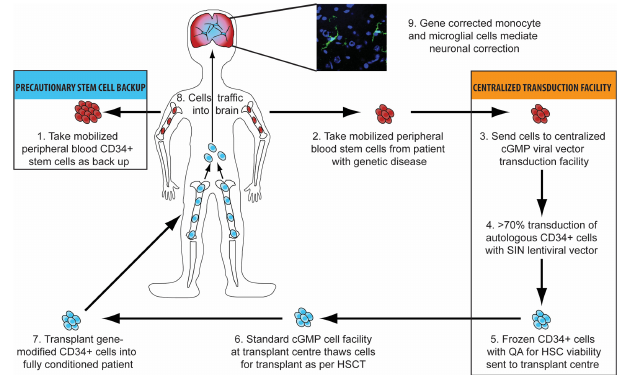
Figure 1. Schematic proposing how autologous stem cell gene therapy can be used to treat inherited neurological disorders. Mobilised peripheral blood CD34+ stem cells are harvested and sent to a centralised transduction facility. Here, they are transduced with an SIN–lentiviral vector before being frozen and returned to the transplant centre. Quality assurance ensures HSC number and viability as well as transduction efficiency prior to patients receiving full myeloablative conditioning. Gene-modified cells are transplanted into the conditioned recipient and then trafficked into the brain, where they engraft as microglial-like cells and thus deliver enzyme effectively to brain cells.